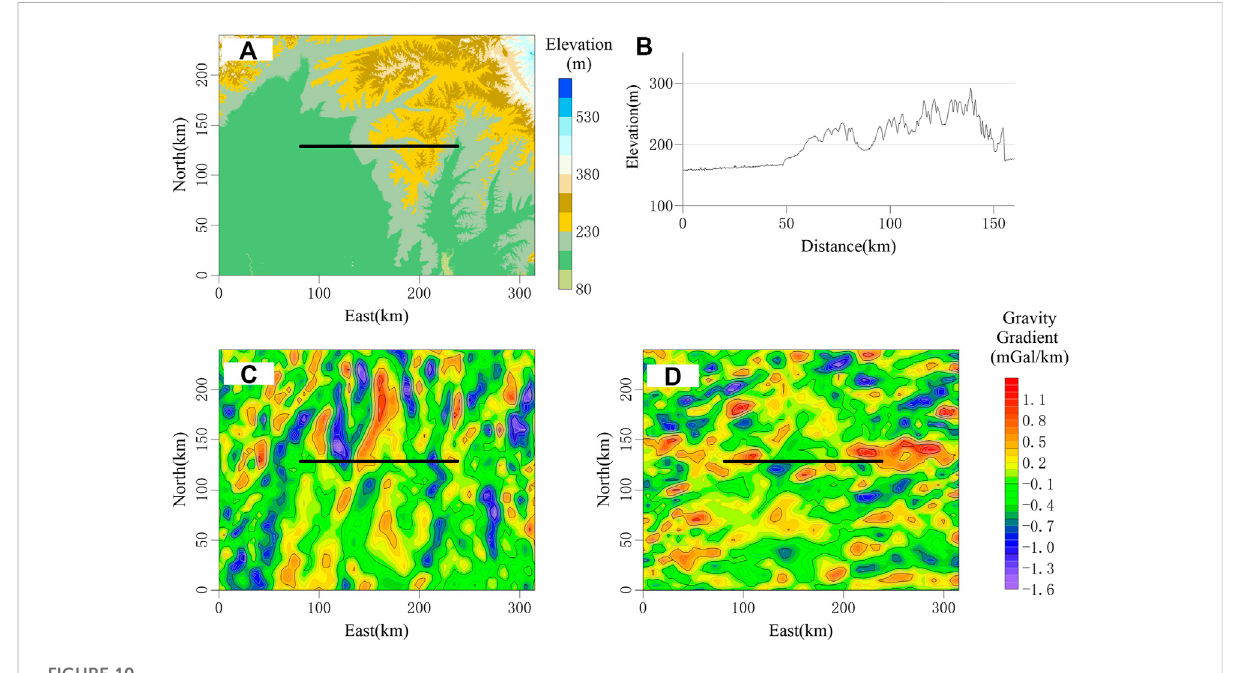
FIGURE 10 Anomalymapofhorizontalgravitygradientinthestudyarea. (A) Topographicmapofthestudyarea(https://lpdaac.usgs.gov/product_search/? collections=Terra+ASTER&status=Operational&view=list). (B) Topographic data curve at seismic line. (C) Horizontal gravity gradient in the east – west direction. (D) Horizontal gravity gradient in the north – south